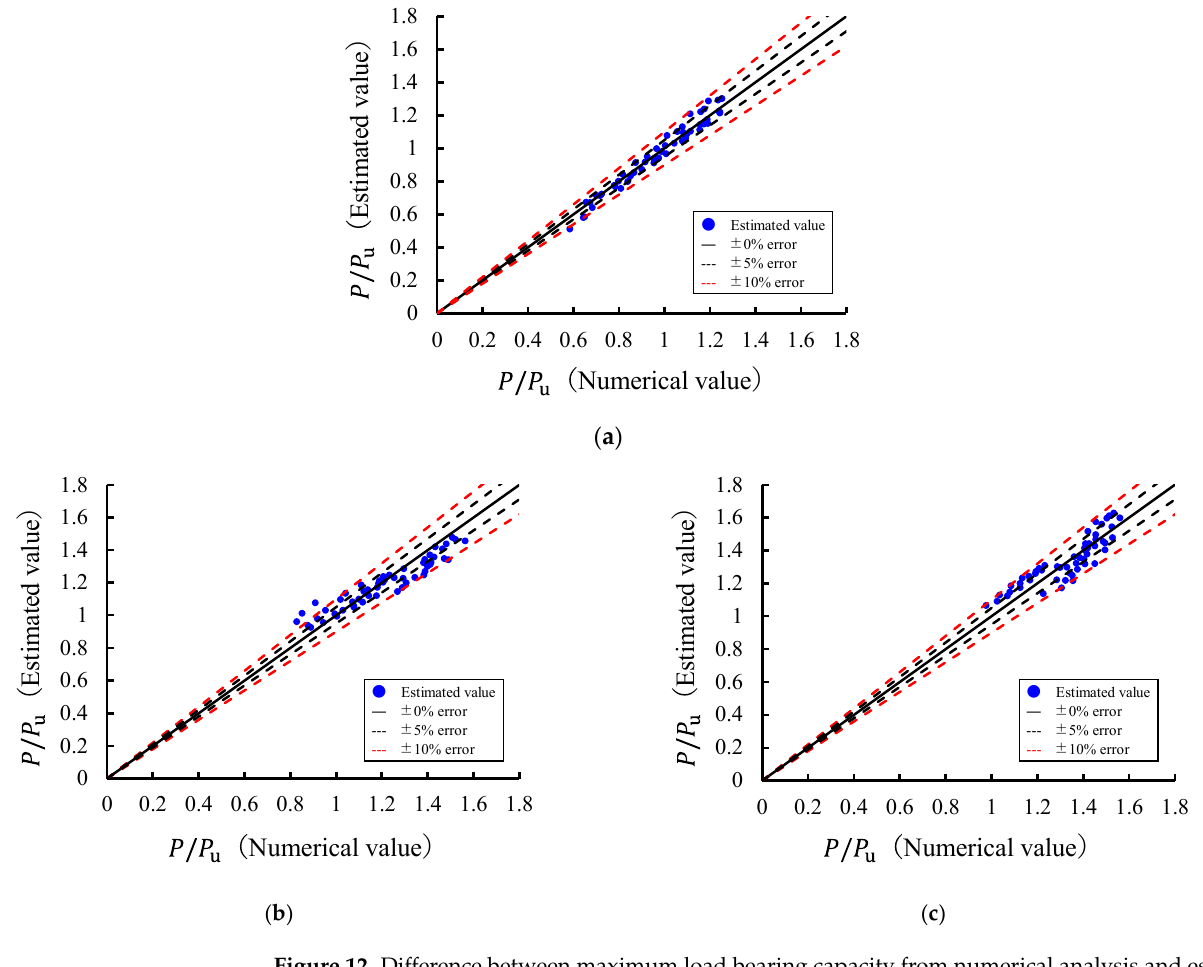
Figure 12. Difference between maximum load bearing capacity from numerical analysis and estimation equation: ( a ) L c / L = 0.2; ( b ) L c / L = 0.4; ( c ) L c / L =